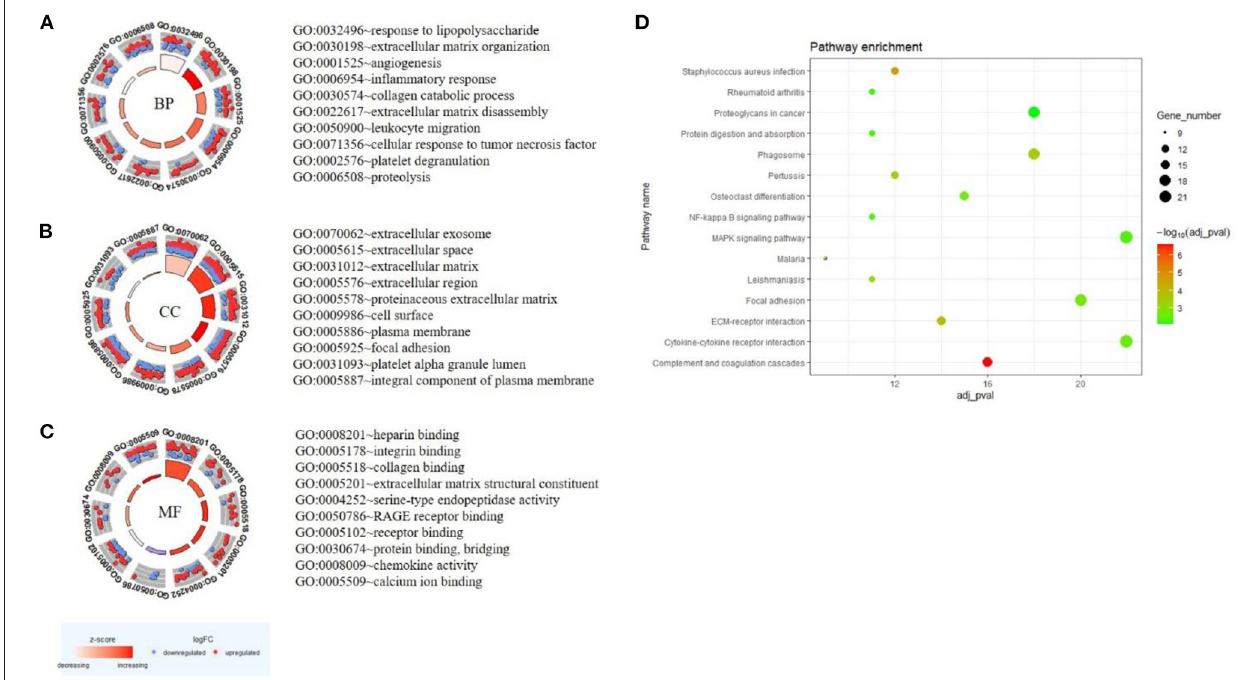
FIGURE 3 | GO and KEGG enrichment result of DEGs. The result of the top 10 enrichment genes is shown in the GOCircle plot: BP (A) , CC (B) , MF (C) . The inner ring is a bar plot where the bar height indicates the significance of the term ( p -value) and the color indicates the z-score. The outer ring displays scatterplots of the expression levels (logFC) for the genes in each term. The blue node is the downregulated gene, and the red node is the upregulated gene. (D) The top 15 KEGG enrichment results. The x-axis represents gene number and the y-axis represents KEGG terms. The size of the circle represents gene count. Circles of different colors represent different adjusted p